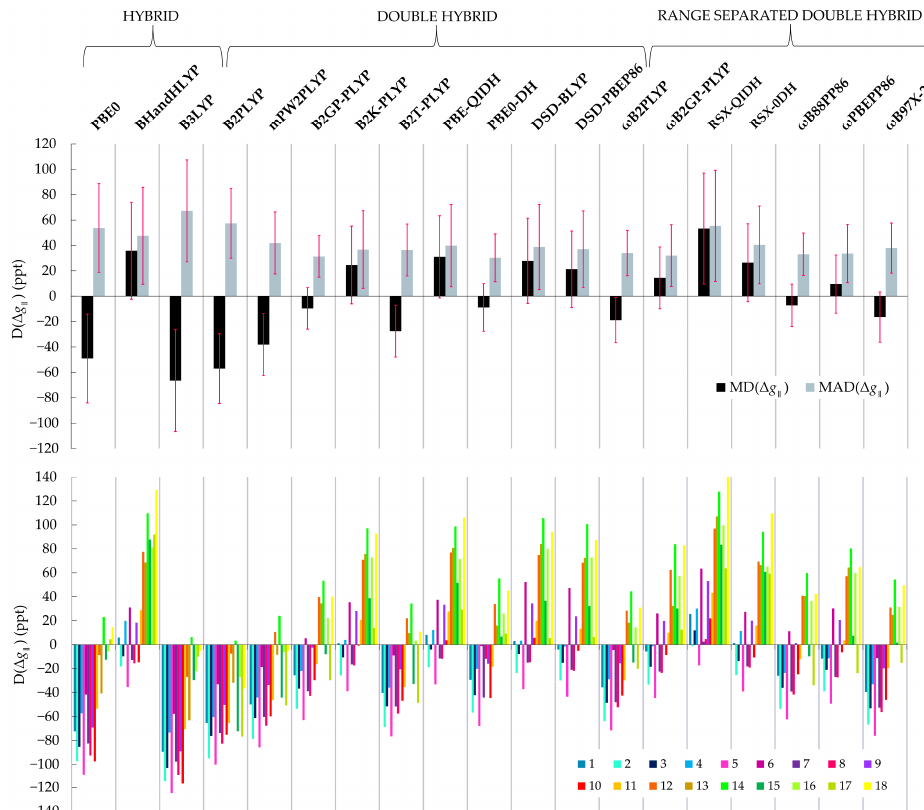
Figure 2. ( Top ): Mean absolute difference (MAD), mean difference (MD) from the experimental values of the parallel g -tensor component calculated with each functional. The respective standard deviations (SD) are plotted in pink. ( Bottom ): Differences (D) from the experimental values of the parallel g -tensor component of each one of the 18 Cu(II) complexes of the set calculated with each functional. Each bar color represents a